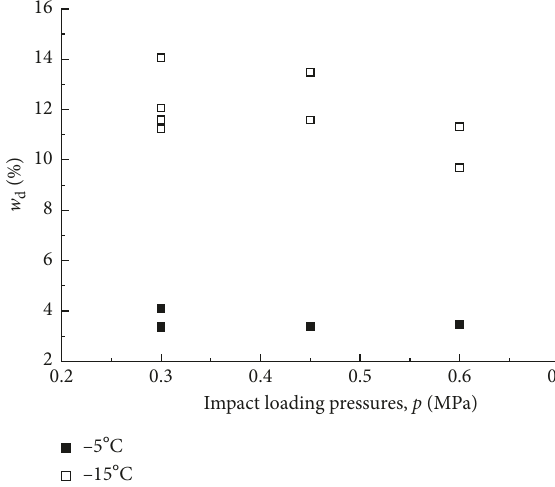
Figure 5: Absorbed energy of Group A under different test conditions.